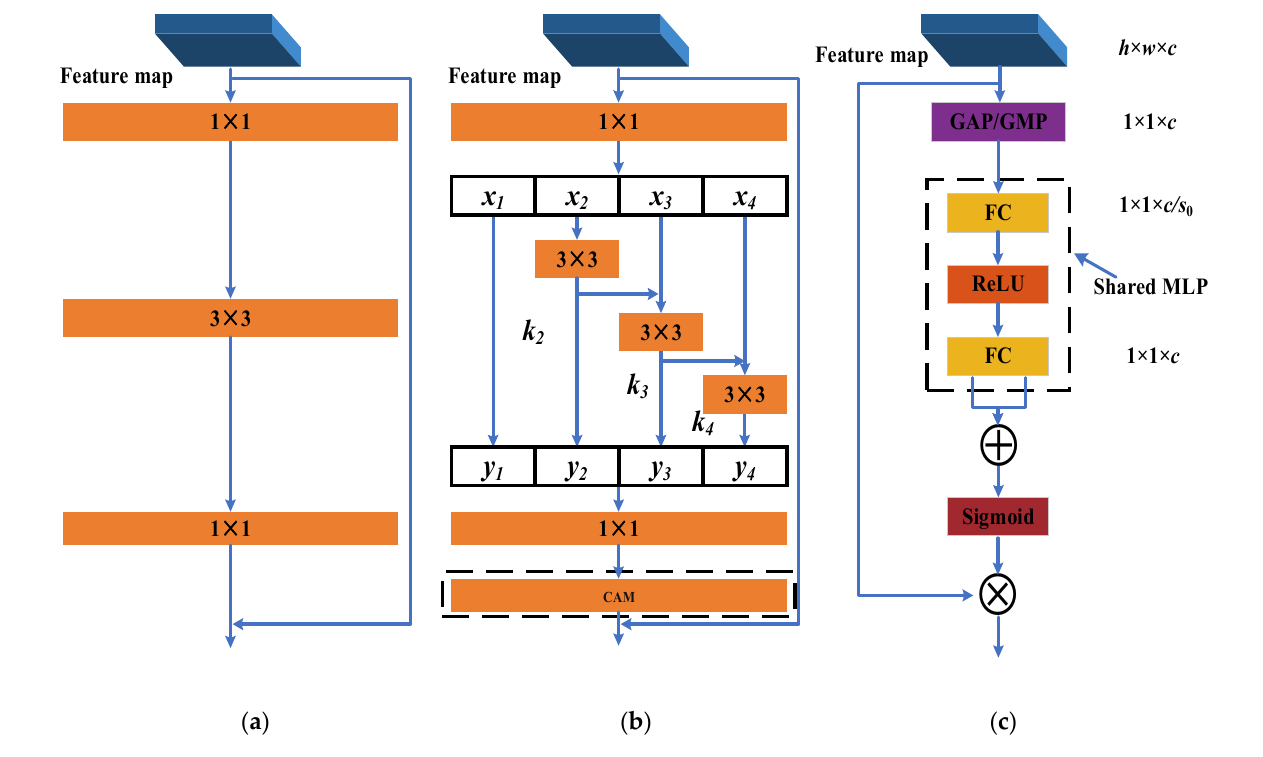
Figure 2. The Res2net module and CAM module. ( a ) Resnet module; ( b ) Res2net/CAM–Res2net module; ( c ) CAM module.